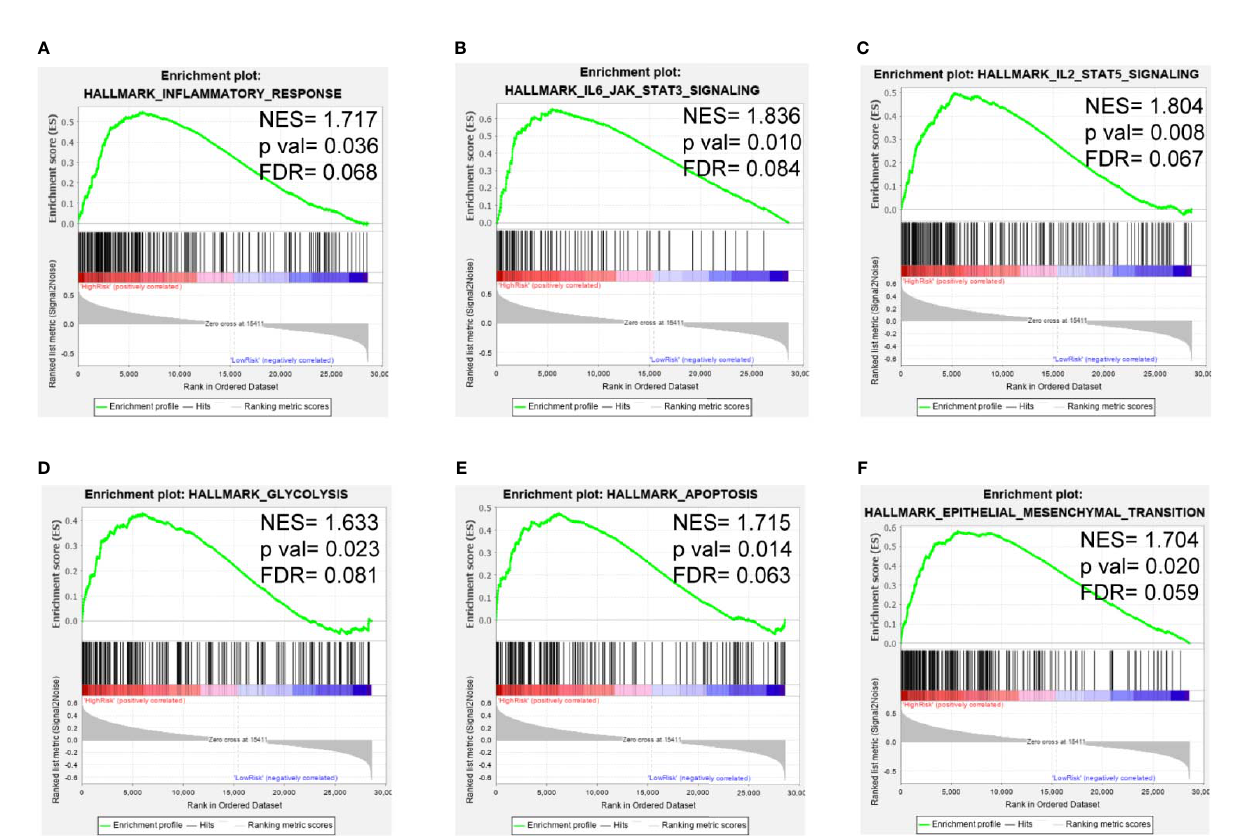
FIGURE 7 | GSEA of the iron metabolism-related gene signature in the TCGA cohort. (A – F) , in fl ammatory response, IL6/JAK/STAT3 signaling pathway, IL2/STAT5 signaling pathway, glycolysis, apoptosis and the EMT were enriched in the high-risk